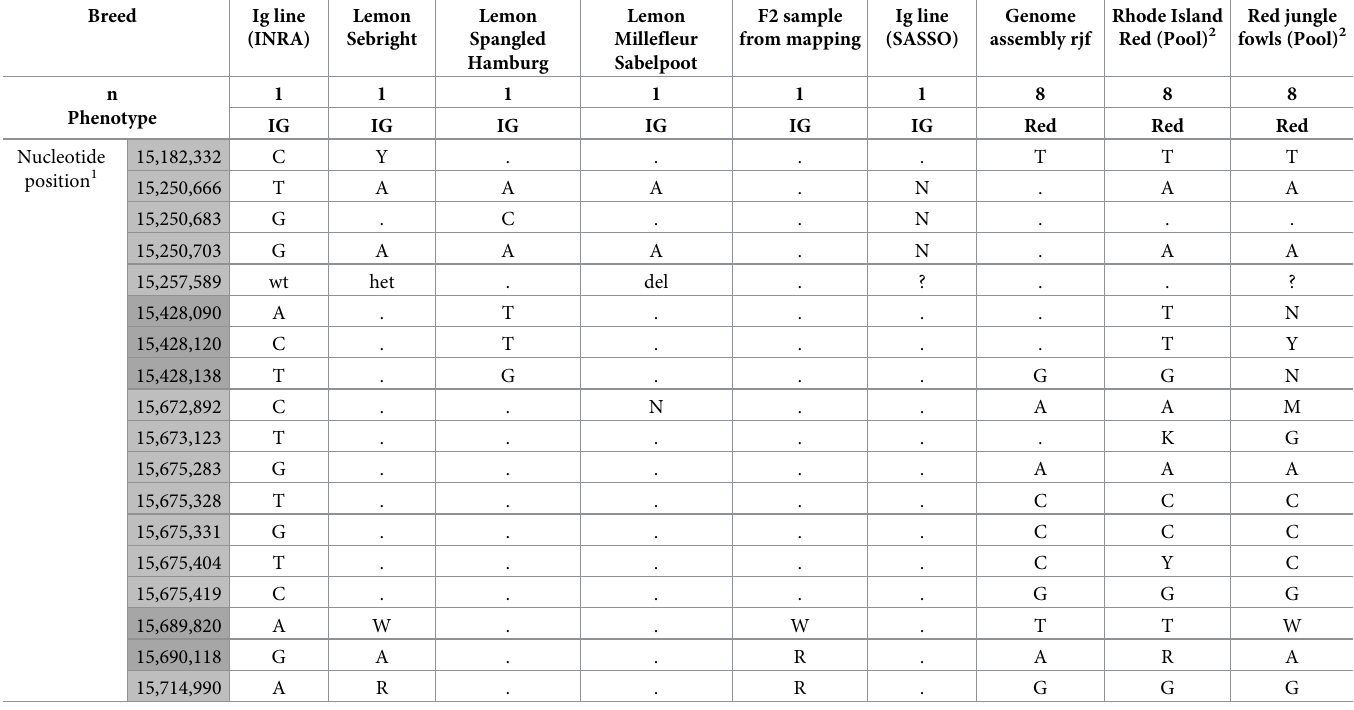
Table 2. Genotype data at SNP positions of the IG locus used for identical-by-descent mapping. Breed Ig line Lemon Lemon (INRA) Sebright Spangled